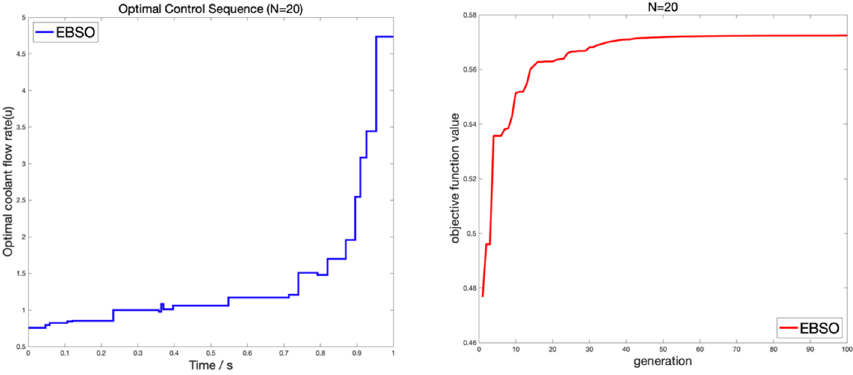
Figure 35. Optimal control trajectory and iteration curve ( N = 20).